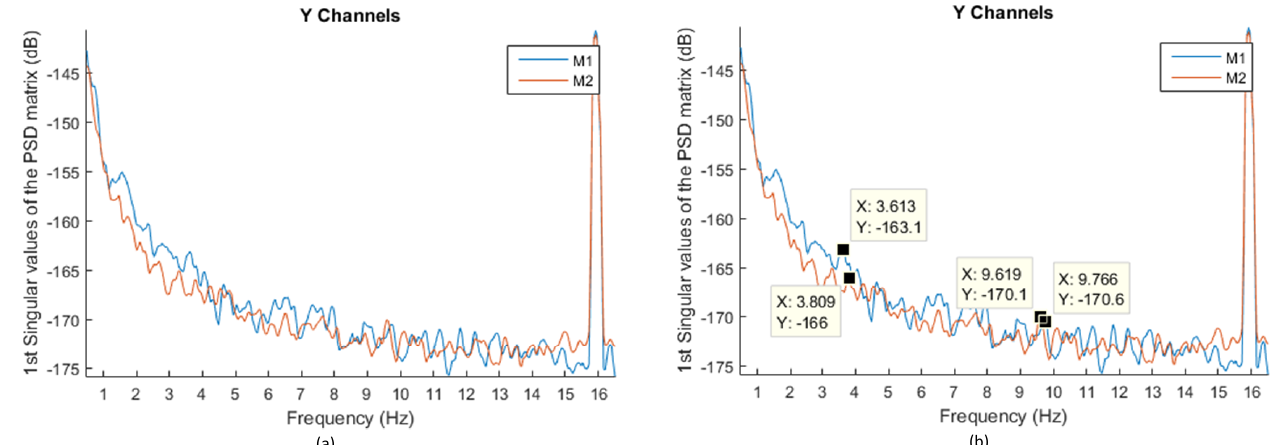
Figure 20. Comparison between the PSD of Y channels of the two measurements. ( a ) General comparison. ( b ) Selected peaks.